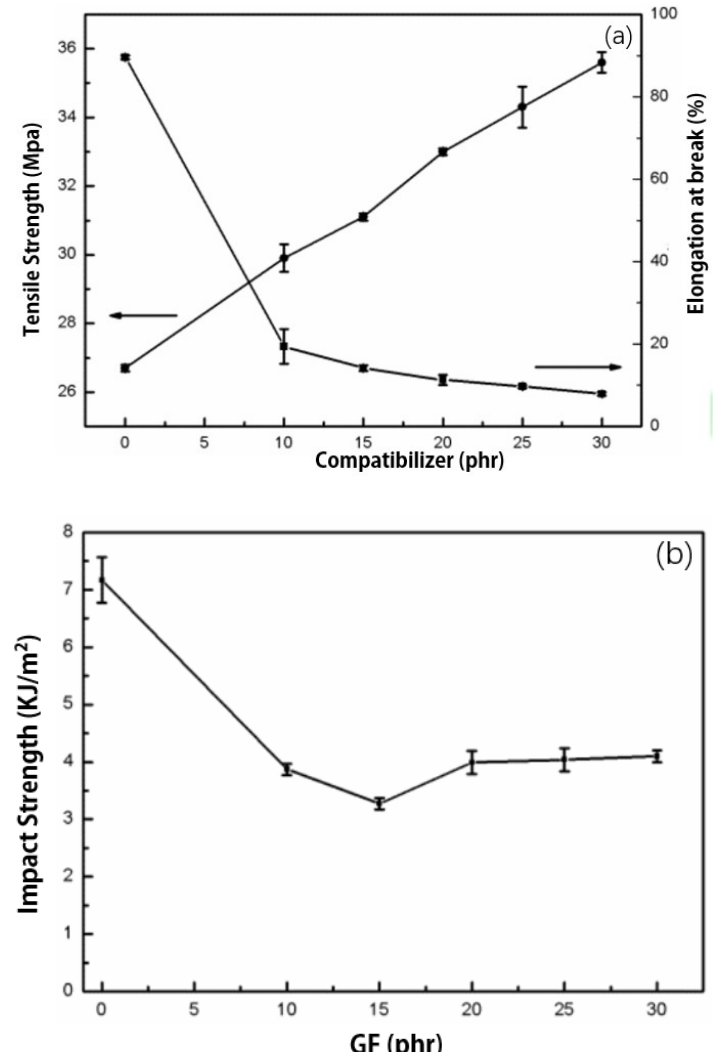
Figure 1. Effects of glass fiber contents on the properties of glass fiber-reinforced polypropylene (GFRP): ( a ) Tensile and elongation properties; ( b ) impact strength.